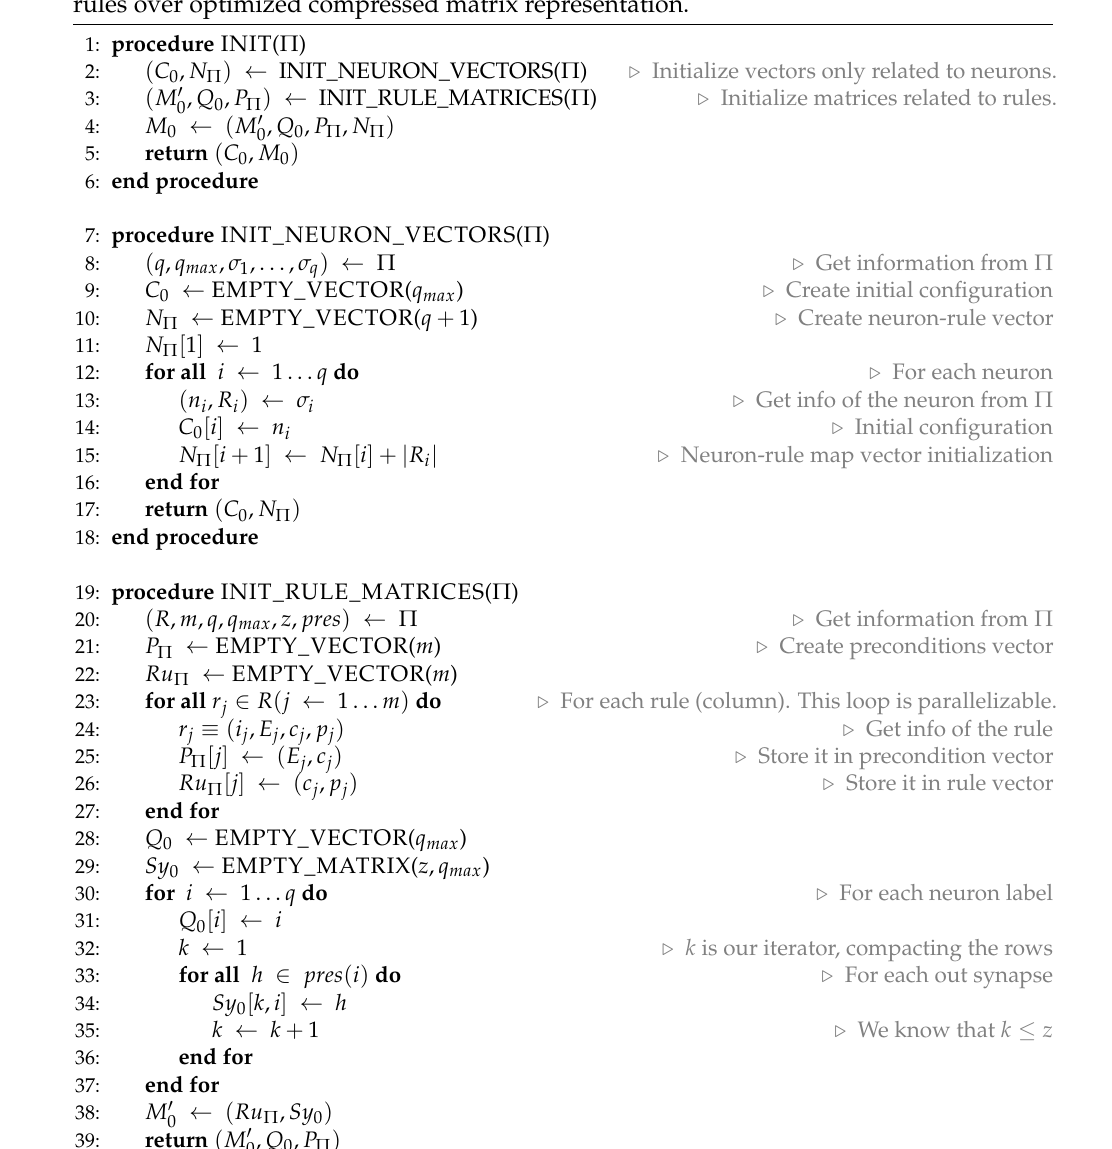
Algorithm 7 Initialization functions for dynamic SNP systems with budding and division rules over optimized compressed matrix